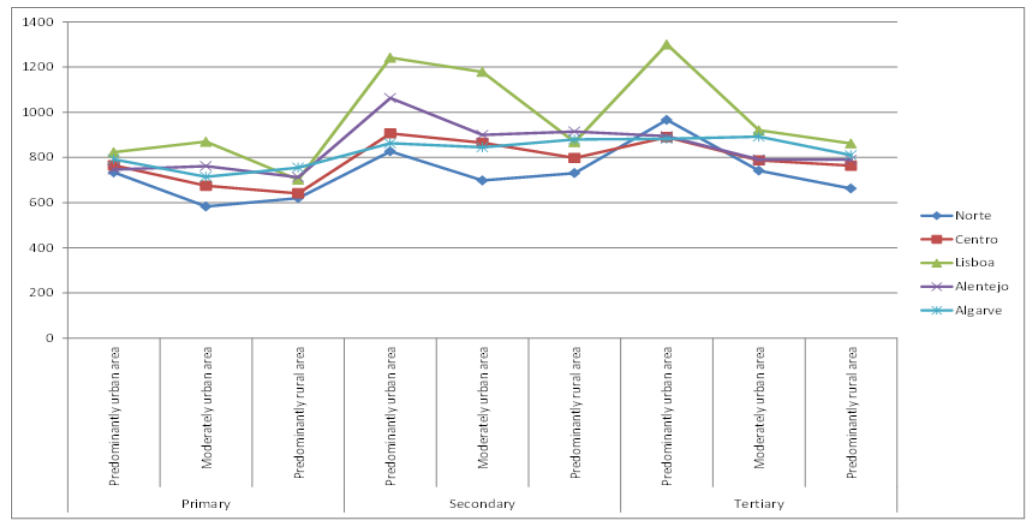
Figure 1. Monthly average earnings (euros) for workers over the period 2004 – 2012, across Portuguese mainland NUTS II, using the gender and the area typology as factors of comparison.